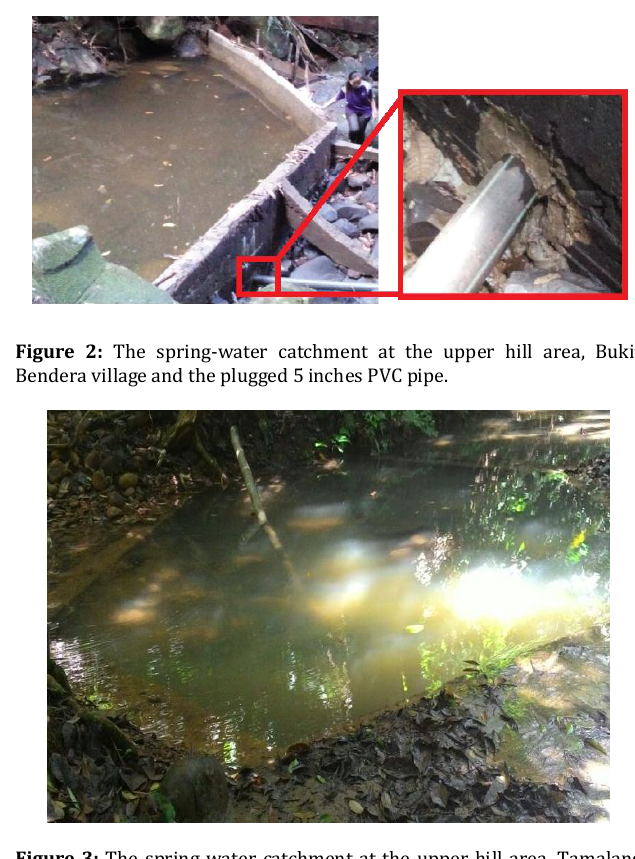
Figure 3: The spring-water catchment at the upper hill area, Tamalang village. Table 1: Coordinate for sampling